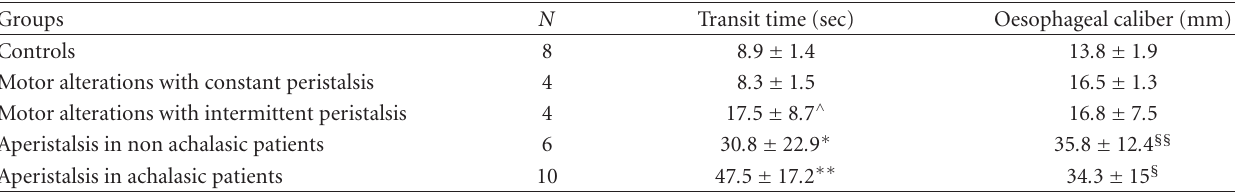
Table 1: Esophageal transit time and size in patients and controls measured by